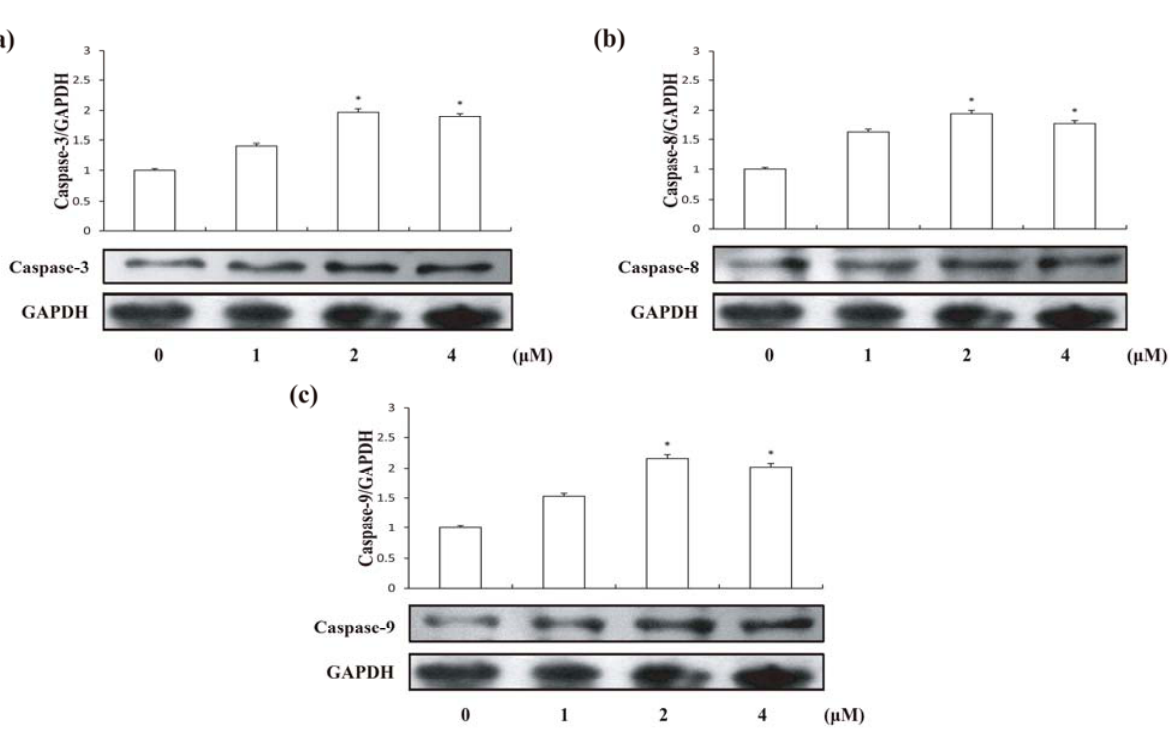
concentrations for 24 h. ( a ) Caspase-3; ( b ) Caspase-8; ( c ) Caspase-9. Results are expressed as mean ± SD (n = 3). * p < 0.05, significantly different from the untreated